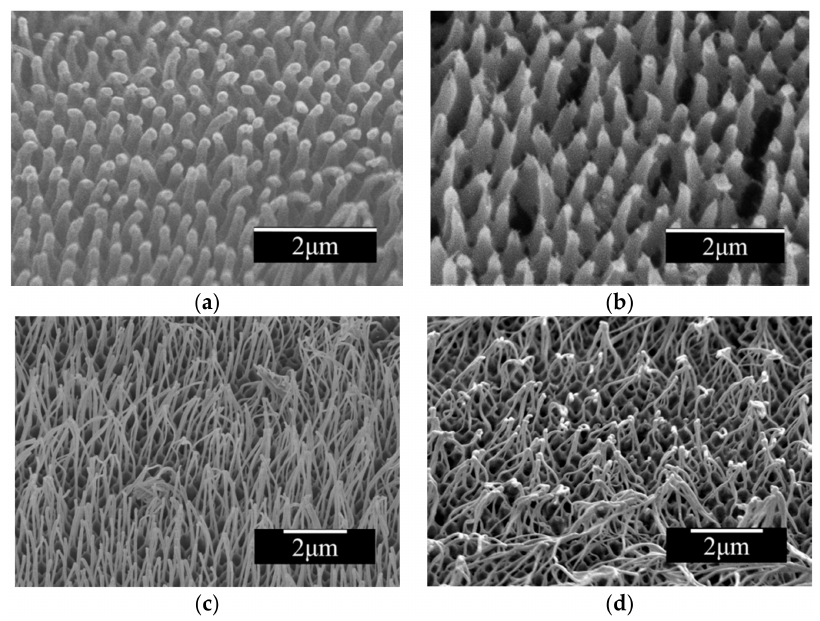
Figure 5. SEM images of nanowire structures replicated using the AAO molds with different aspect ratios, including ( a ) VM-01, ( b ) SP-03, ( c ) LJ-05, and ( d ) LJ-04 molds, respectively (see Table 1 for the details of the dimensions of the different AAO molds).